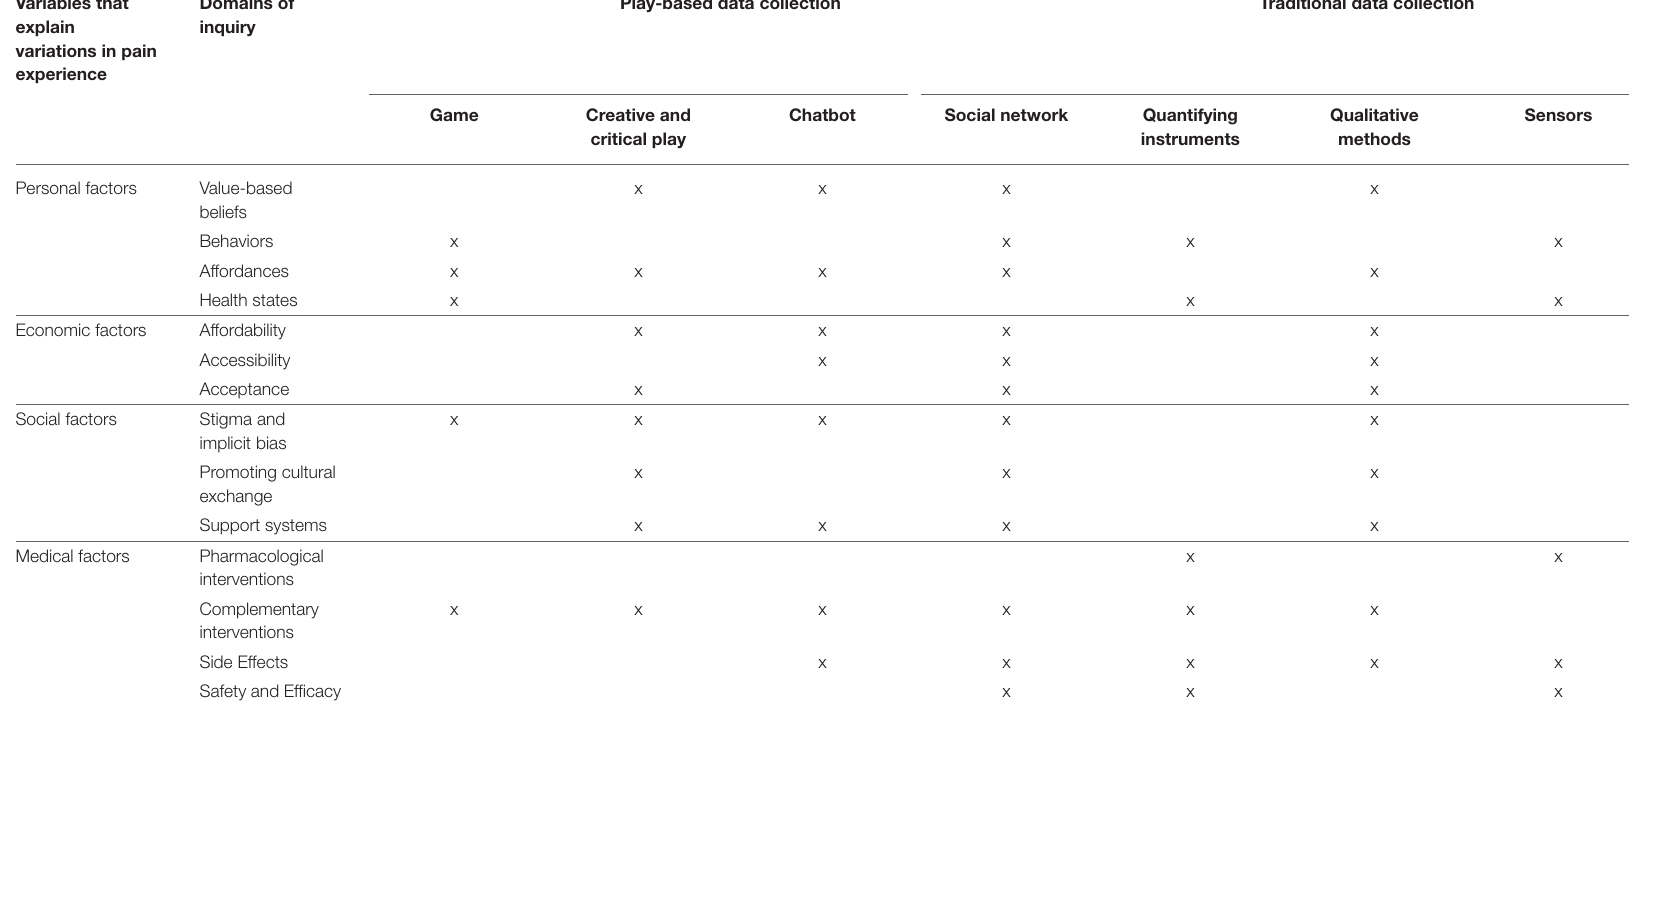
TABLE 2 | Research questions, domains of inquiry and potential modes of data collection about factors that influence chronic pain experience and treatment. Variables that